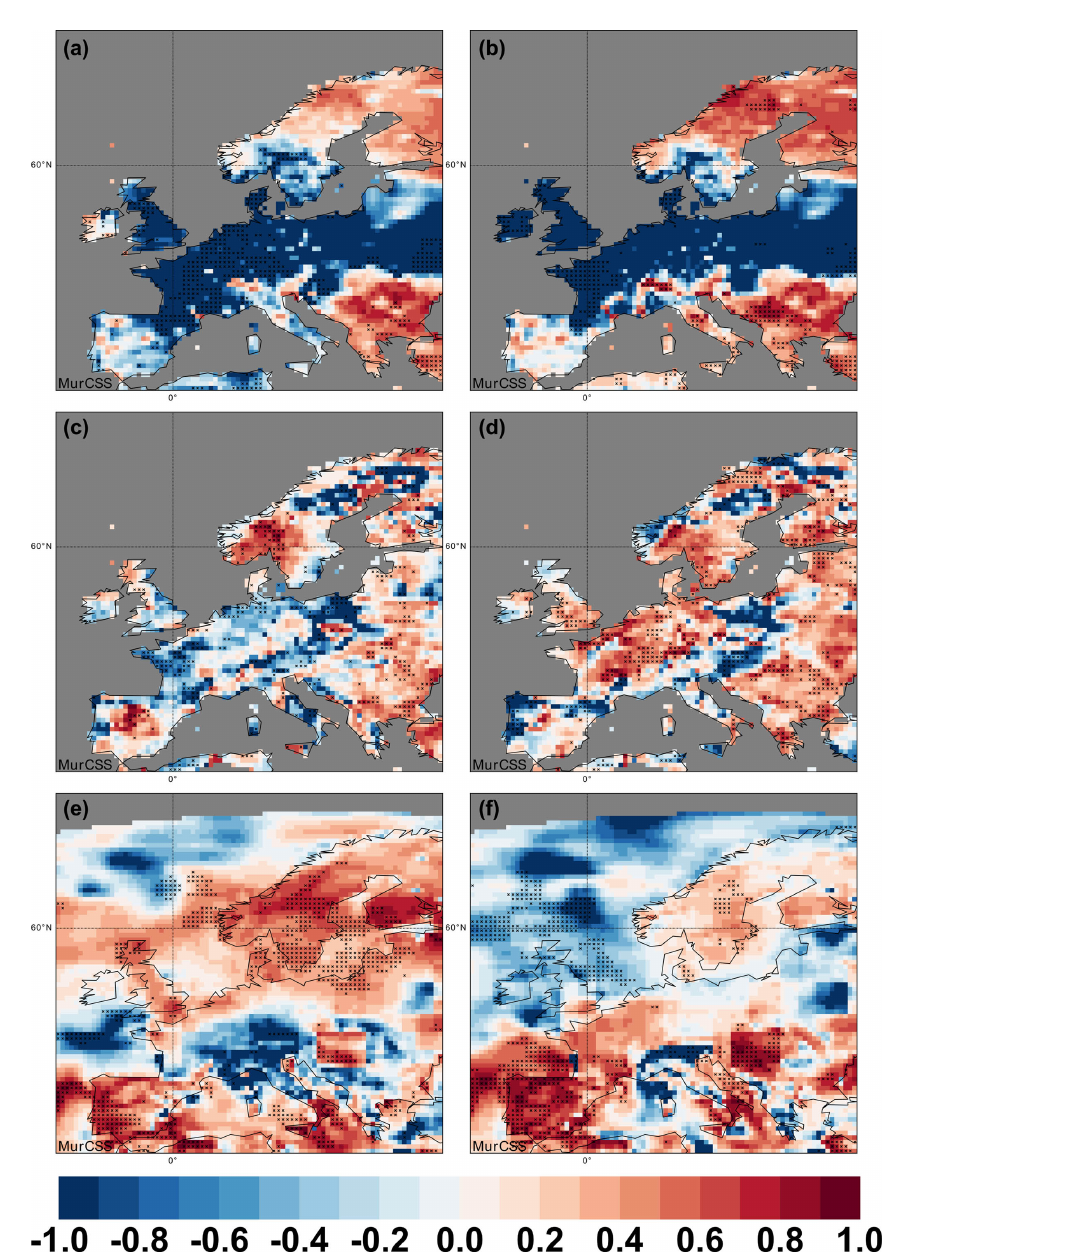
Figure 3. Spatial distribution of the MSESS for the multi-annual mean anomalies of lead years 1–5 for (a) temperature in CCLM_b0, (b) temperature in CCLM_b1, (c) precipitation in CCLM_b0, (d) precipitation in CCLM_b1, (e) wind speed in CCLM_b0, and (f) wind speed in CCLM_b1. As reference dataset we have used the uninitialized historical ensemble. The black dots indicate significant skill at the 95% level